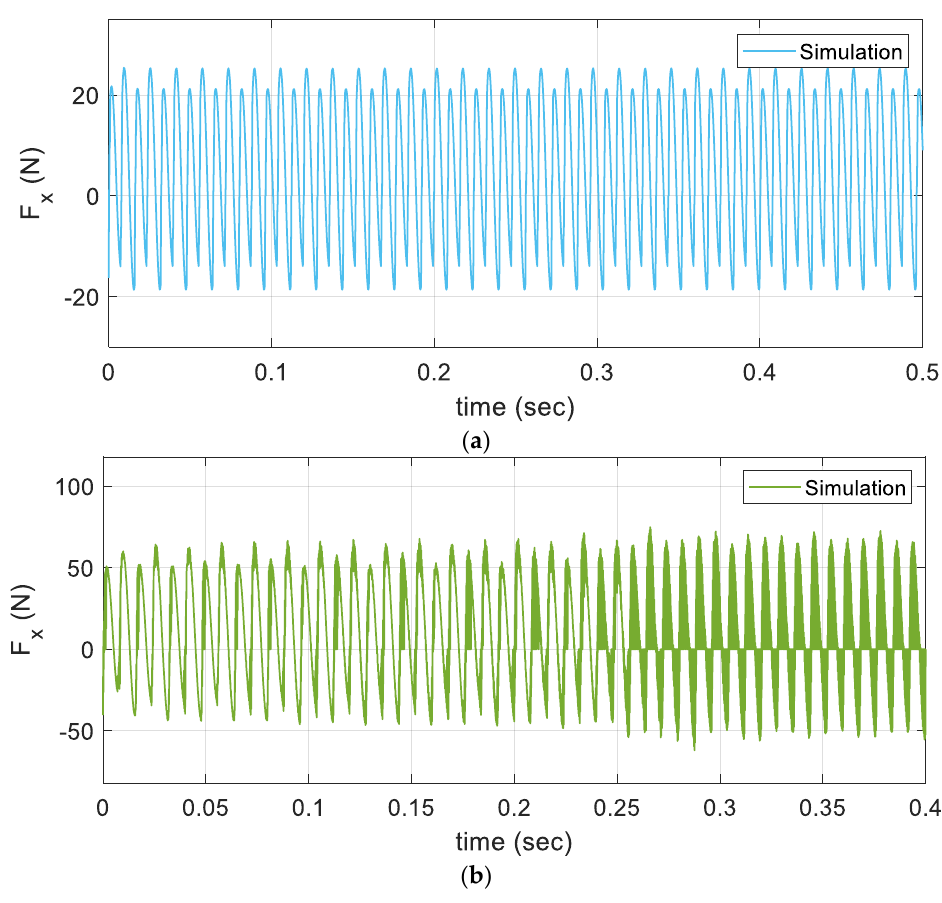
Figure 6. Simulation of cutting force under different cutting conditions: ( a ) stable cutting: 3750 rpm spindle and 0.4 mm cut depth; ( b ) unstable cutting: 3750 rpm spindle and 1.4 mm cut depth.